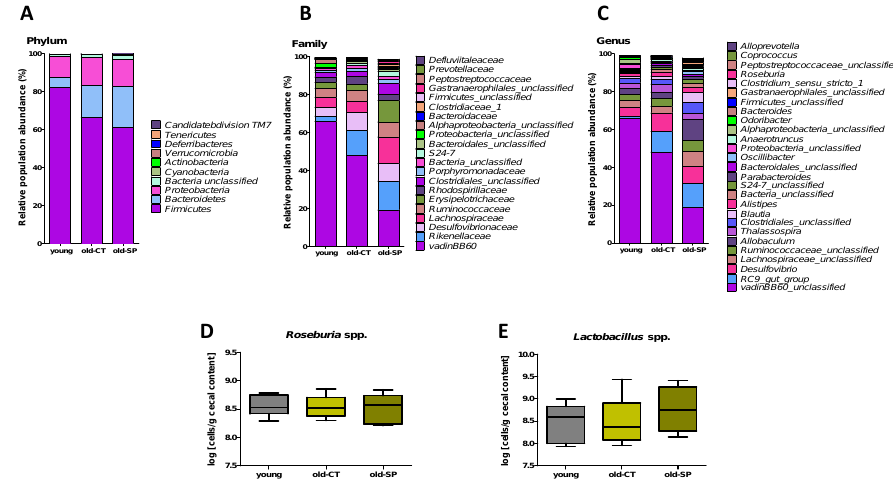
Figure 2. Changes in microbial populations in the caecal content, assessed by 16S profiling ( A – C ) and qPCR ( D – F ). Relative abundances of bacterial phyla ( A ) and bacterial taxa accounting for more than 1%, at the family ( B ) and genus levels ( C ). qPCR analysis of Roseburia spp. ( D ) and Lactobacillus spp. ( E ) in the caecal content. Old mice were fed a standard diet supplemented with or without Spirulina for six weeks and were compared to young mice fed a standard